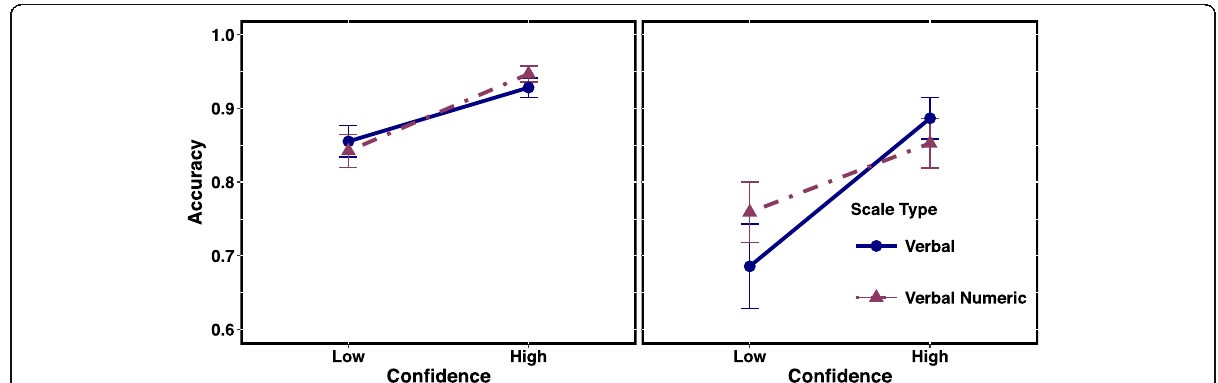
Fig. 3 Comparison of the verbal scale to the verbal and numeric scale for Set A ( left ) and Set B ( right ). Error bars indicate standard